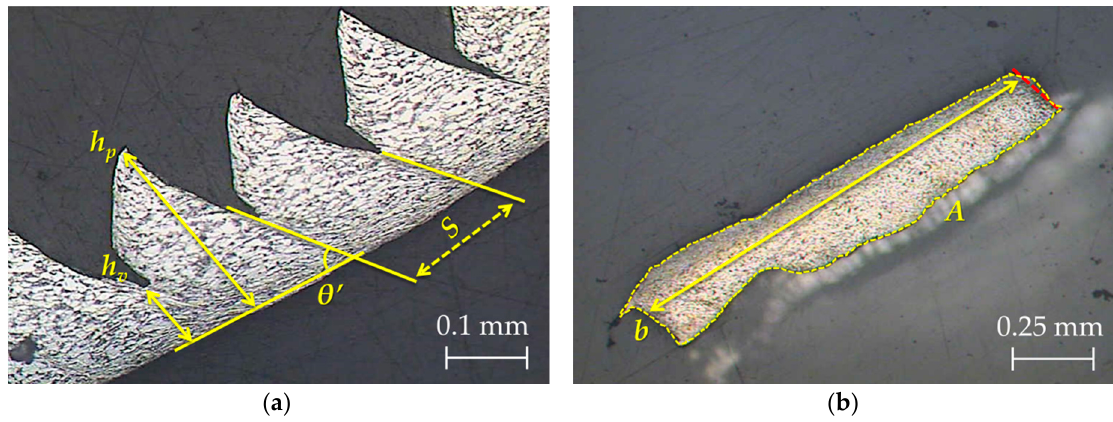
Figure 3. ( a ) Longitudinal and ( b ) transverse chip section measurements.